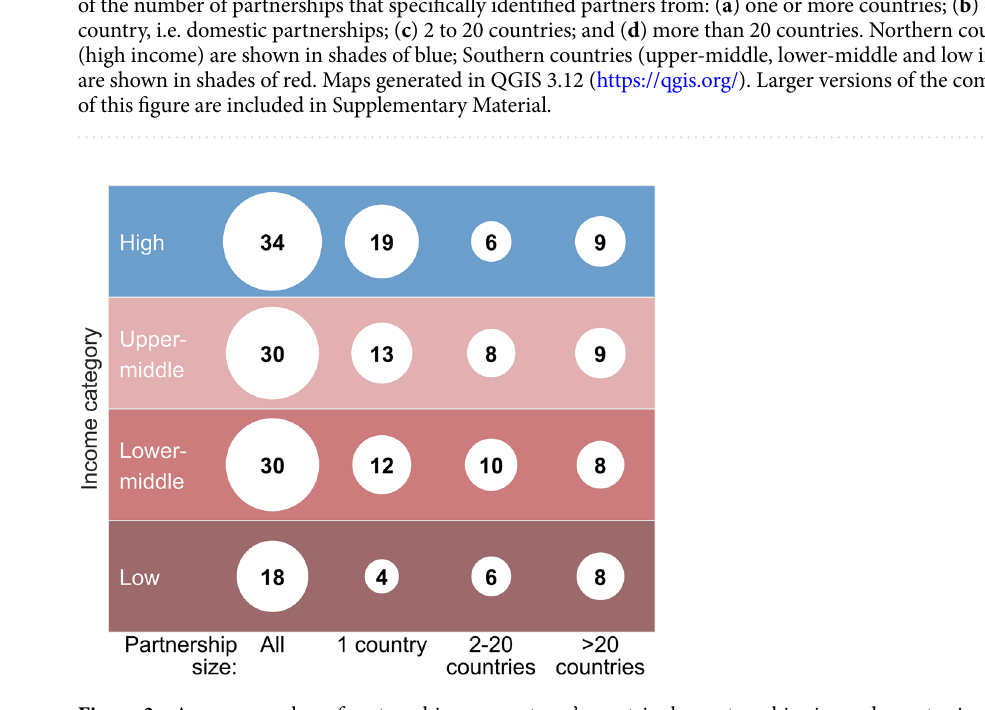
Figure 3. Average number of partnerships per partners’ countries by partnership size and country income category. Figures in the first column are not the sum of figures in the subsequent columns, as all are average